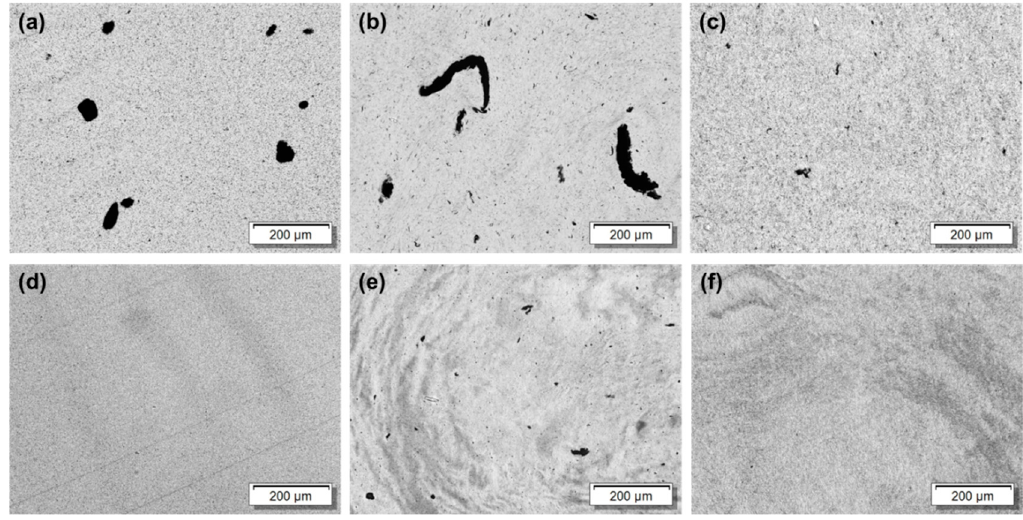
Figure 3. Light microscopy image of a thin section of polymer / 2 wt % CNT composites: PP with MWCNT ( a ), PP with SWCNT ( b ), PP with b-MWCNT ( c ), PVDF with MWCNT ( d ), PVDF with SWCNT ( e ), and PVDF with b-MWCNT ( f ).